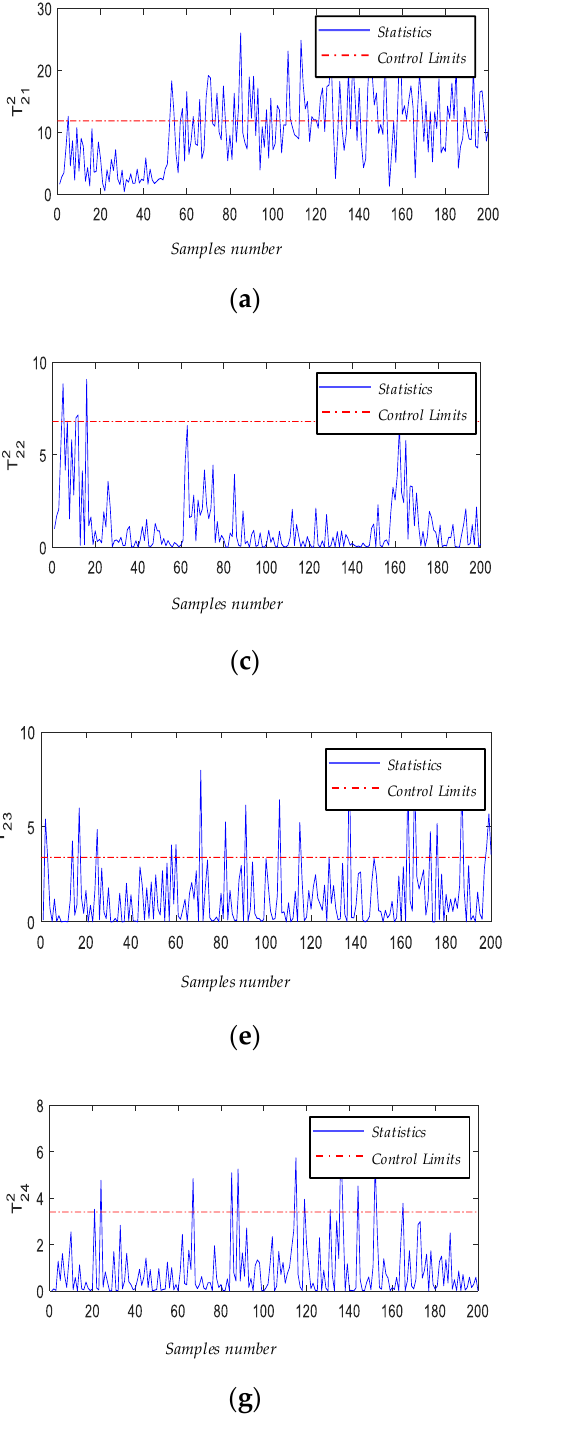
Figure 7. Experimental results of ID-PCA fault detection method for the rolling bearing rolling body: ( a ) the result of T 2 ; ( b ) the result of SPE 21 ; ( c ) the result of T 2 ; ( d ) the result of SPE 22 ; ( e ) the result of T 2 ; ( f ) the result of SPE 23 ; ( g ) the result of T 2 ; ( h ) the result of SPE 24